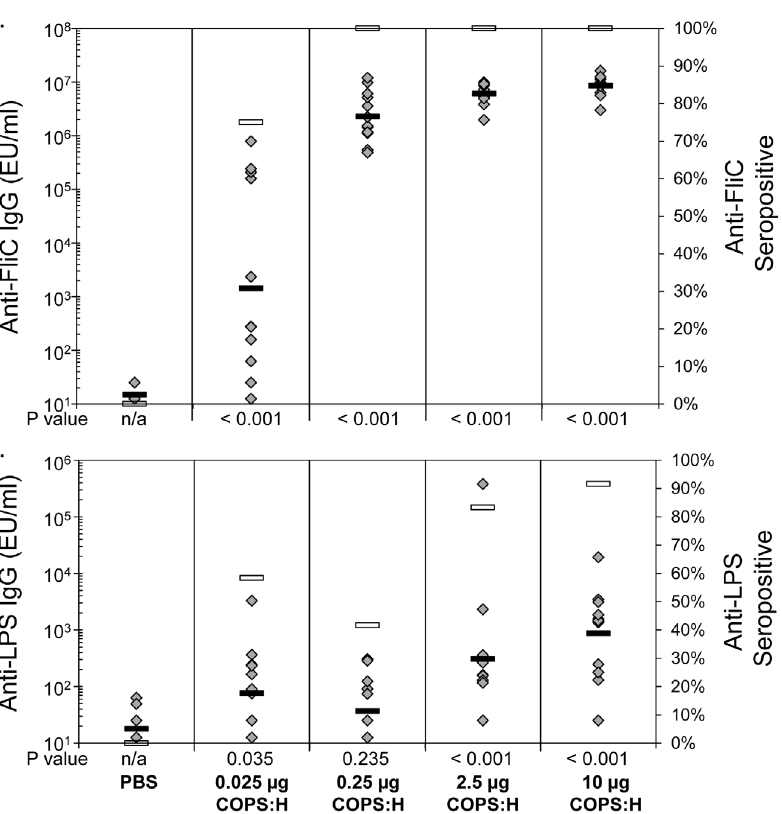
Figure 1. Serum titers and seropositive levels in mice receiving varying doses of COPS:FliC. Mice were immunized with PBS or three doses of the indicated amount of COPS:FliC. Serum was obtained 21 days after the third dose, and levels of specific antibody in individual mice (grey diamonds), and the geometric mean titer (black rectangles) and percent seropositive (white rectangles) within groups were determined by ELISA for A. FliC, or B. LPS. Statistical significance (P values) for COPS:FliC immunized groups relative to PBS controls assessed by Mann-Whitney rank sum test are indicated.